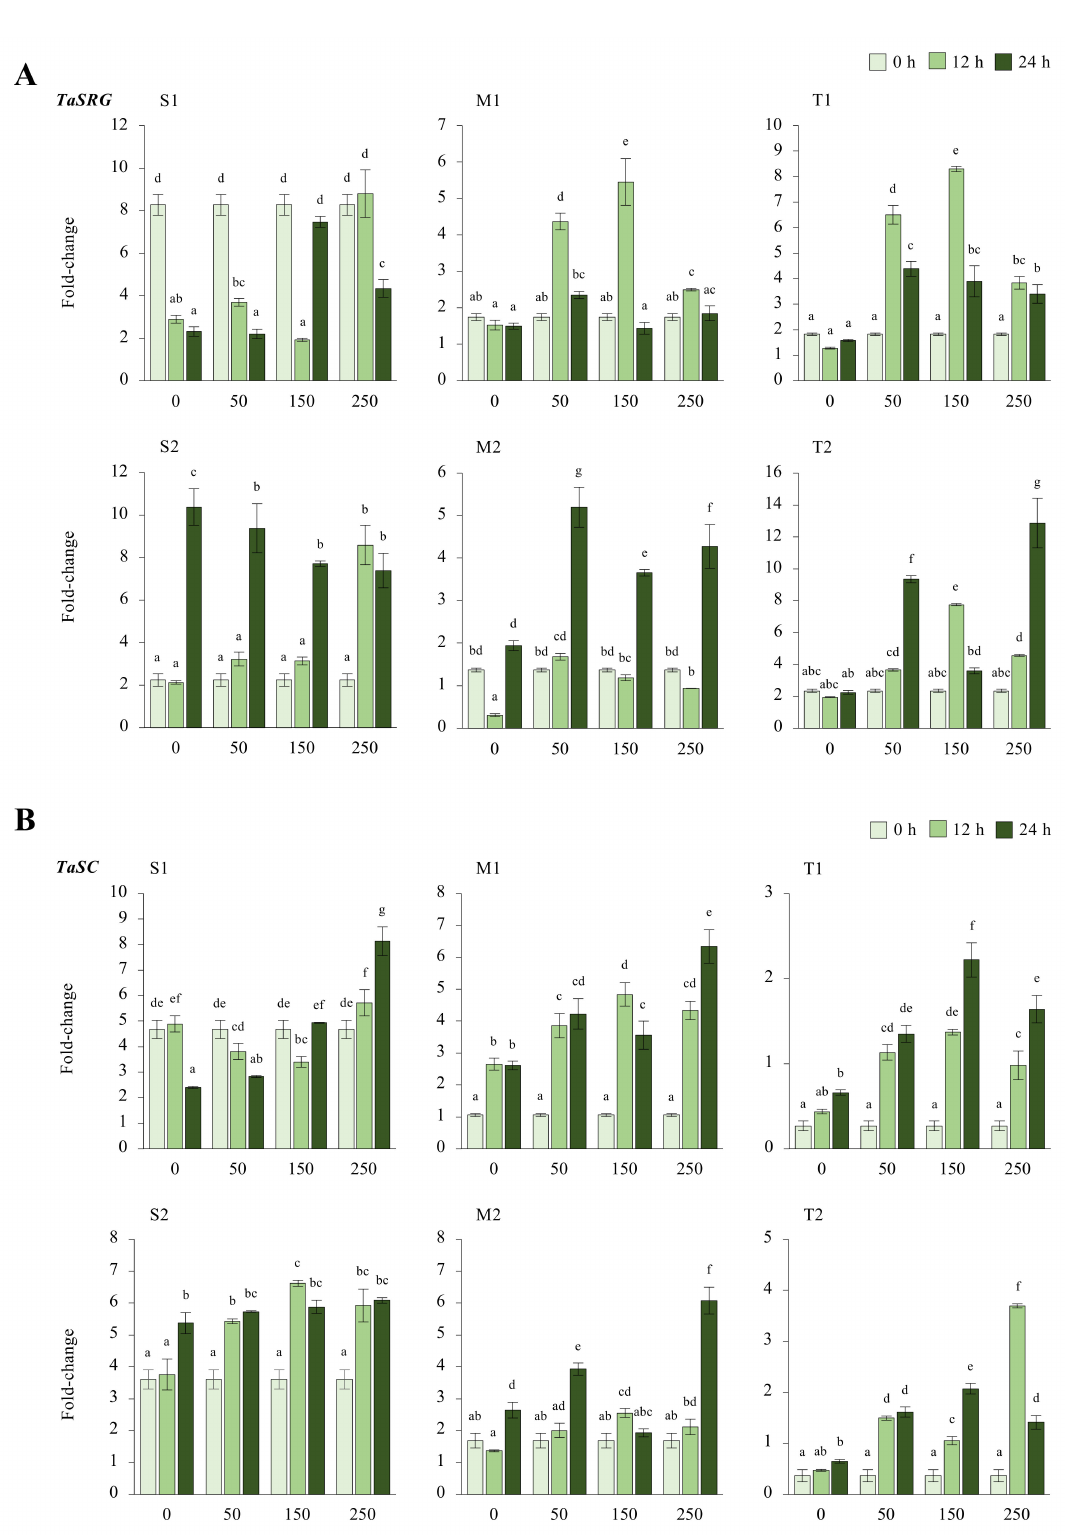
Figure A3. ( A ) The gene expression of the TaSRG , and ( B ) TaSC in the leaves of salt-sensitive (S1), S2, -moderate (M1), M2, -tolerant (T1), and T2 genotypes exposed to 0, 50, 150, and 250 mM NaCl stress for 0, 12, 14 h. The Cq values formed the basis of qRT-PCR. The reference gene TaACTIN was used to standardize the Cq value for each sample. Means ( ± standard deviation) within the same graph followed by letters are significantly different at p < 0.05 according to the Tukey HSD test from independent biological triplicates ( n =